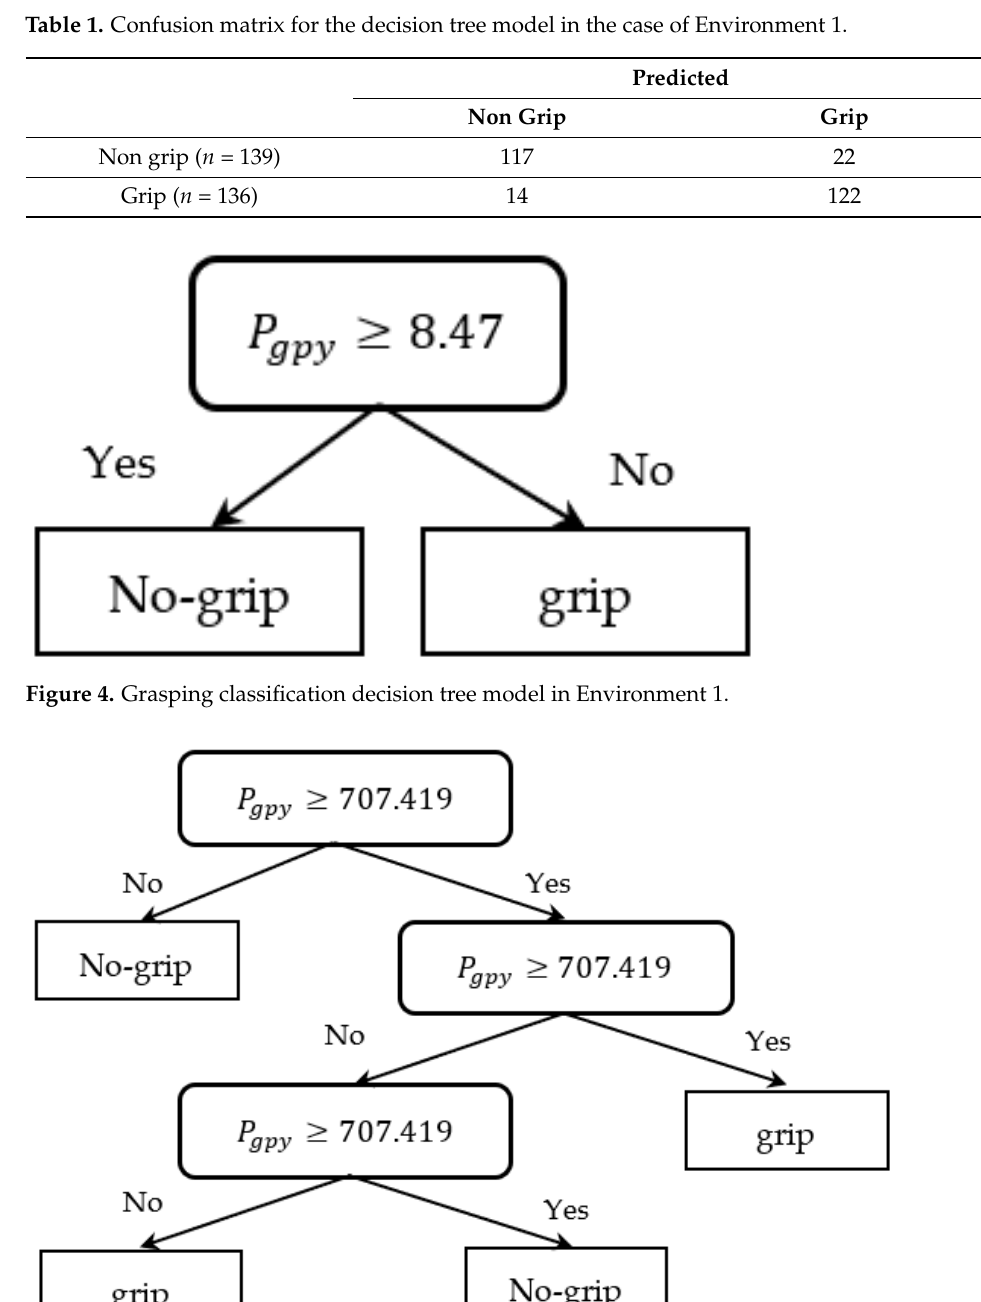
Figure 3. Labeling of the “grasp” or “not grasped” frame.